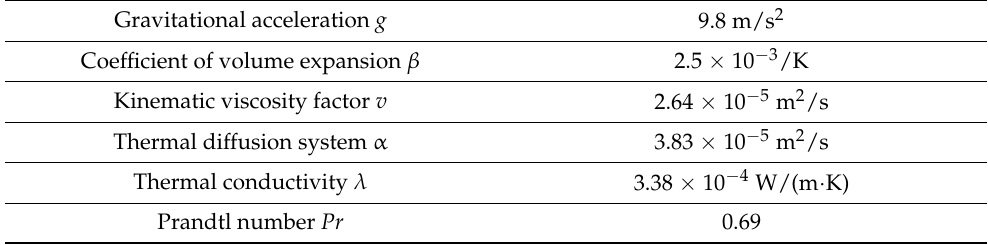
Table A2. Thermophysical parameters of 400 K air.